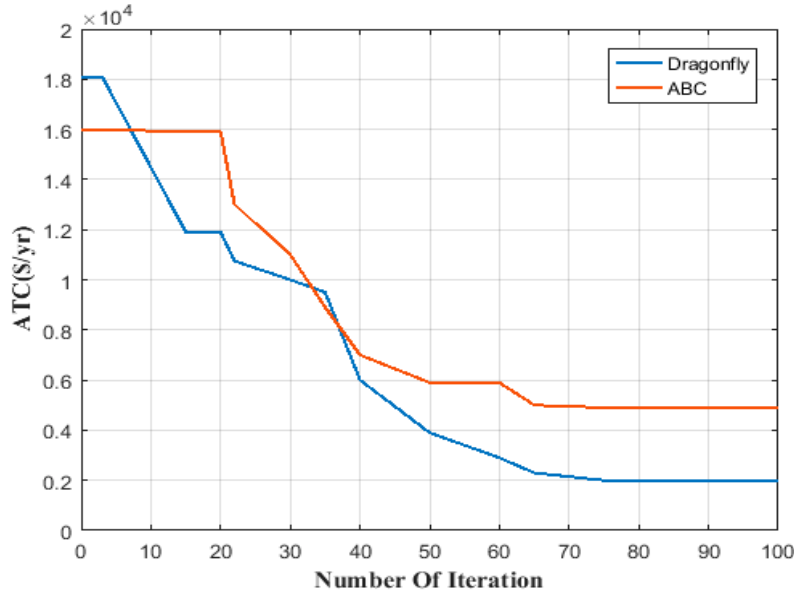
Figure 6. Comparison of ATC vs number of iterations of ABC and DF algorithms.